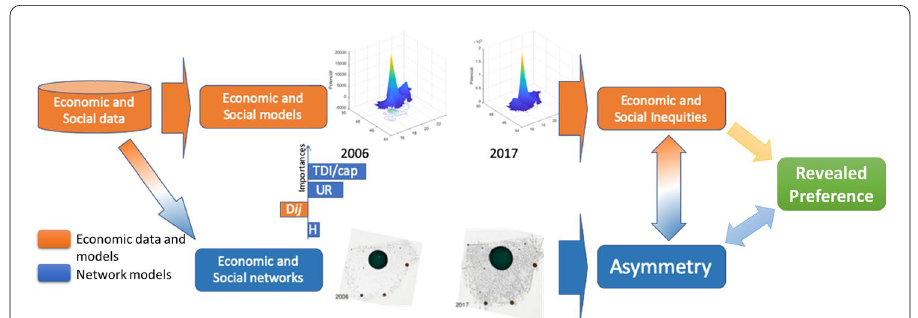
Fig. 1 Combining dynamic network and economic time‑series gravity